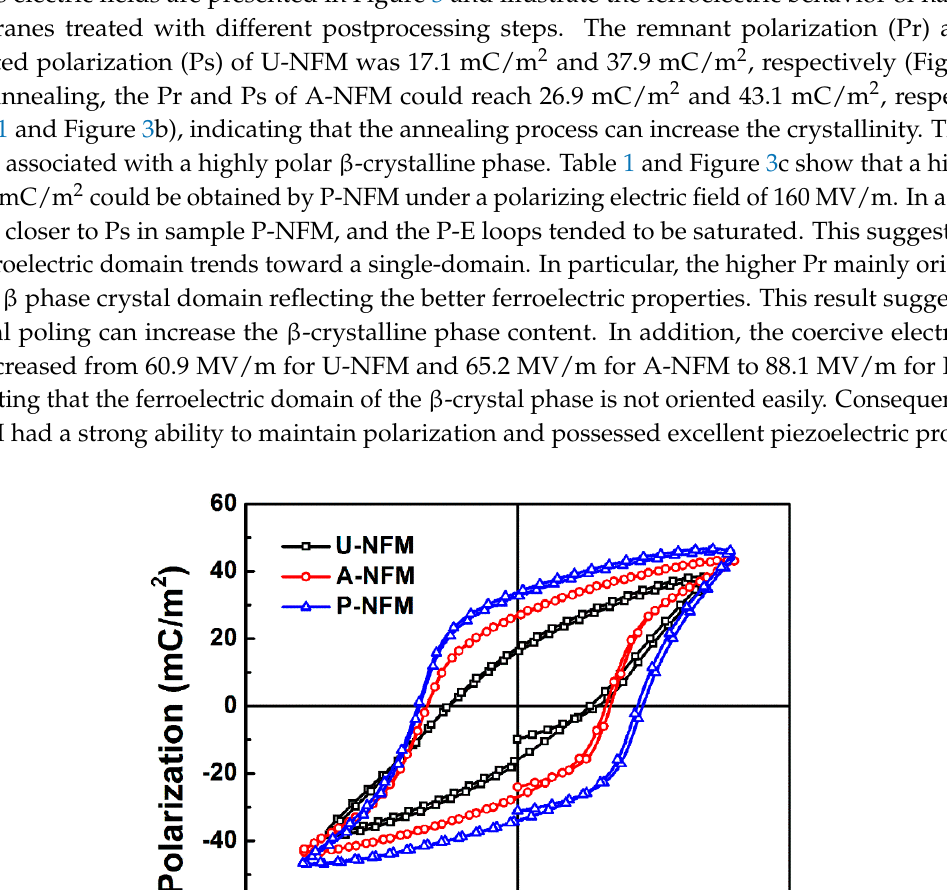
Figure 2. Crystalline characterization of P(VDF-TrFE) NFMs treated with different postprocessing steps. ( a ) X-ray diffraction (XRD) patterns and ( b ) Fourier transform infrared spectroscopy (FTIR) spectra.